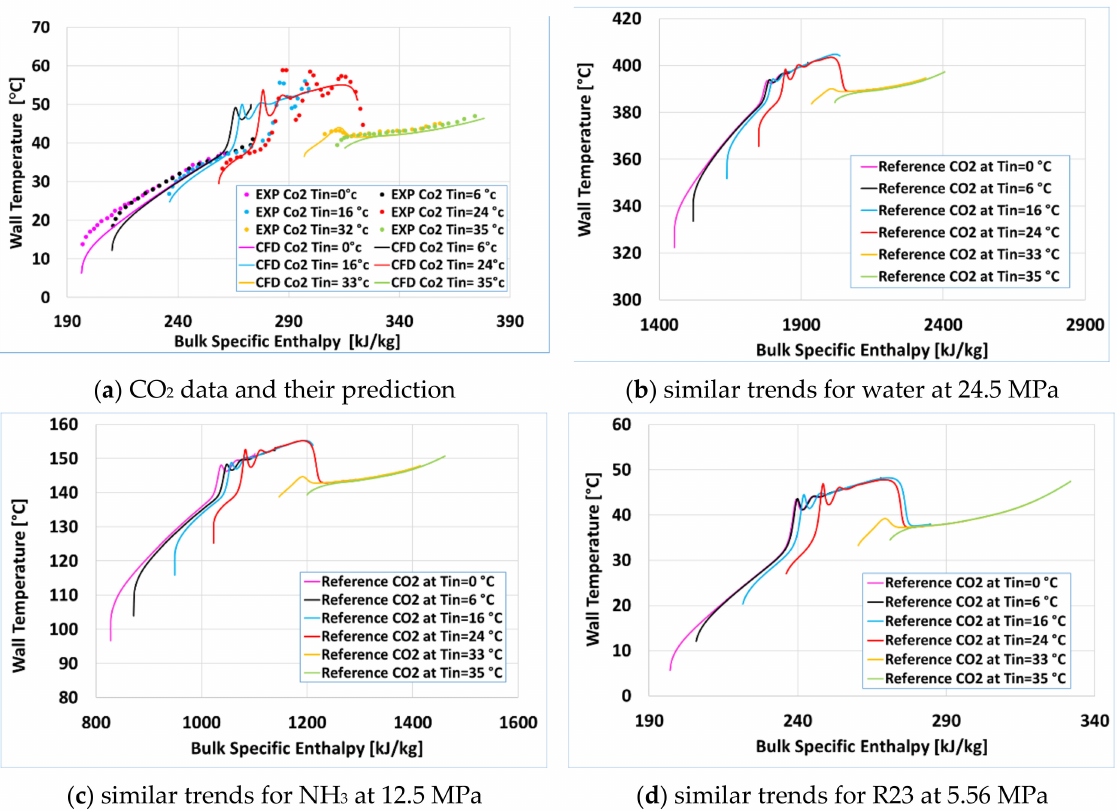
Figure 7. Prediction of Kline’s CO 2 data at q (cid:48)(cid:48) = 18 kW/m 2 , and trends obtained by the application of the similarity theory for water, NH 3 and